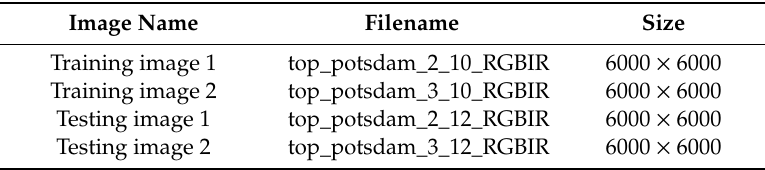
Table 5. Four study images from the Potsdam